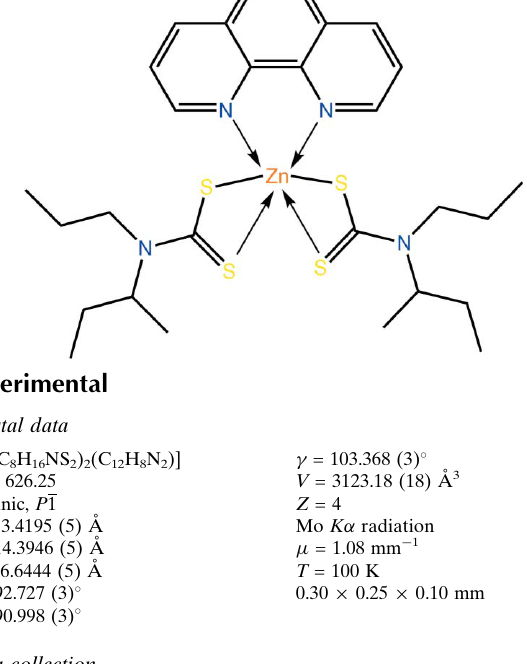
Data collection Oxford Diffraction Xcaliber Eos Gemini diffractometer